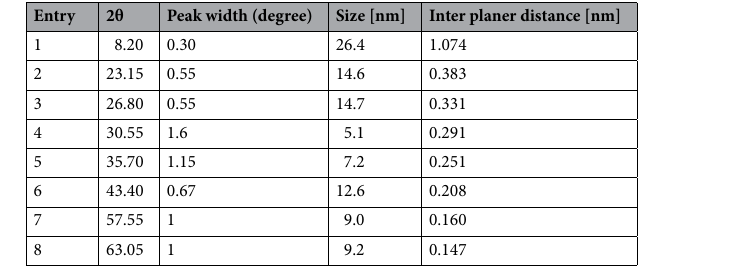
Table 1. XRD data of